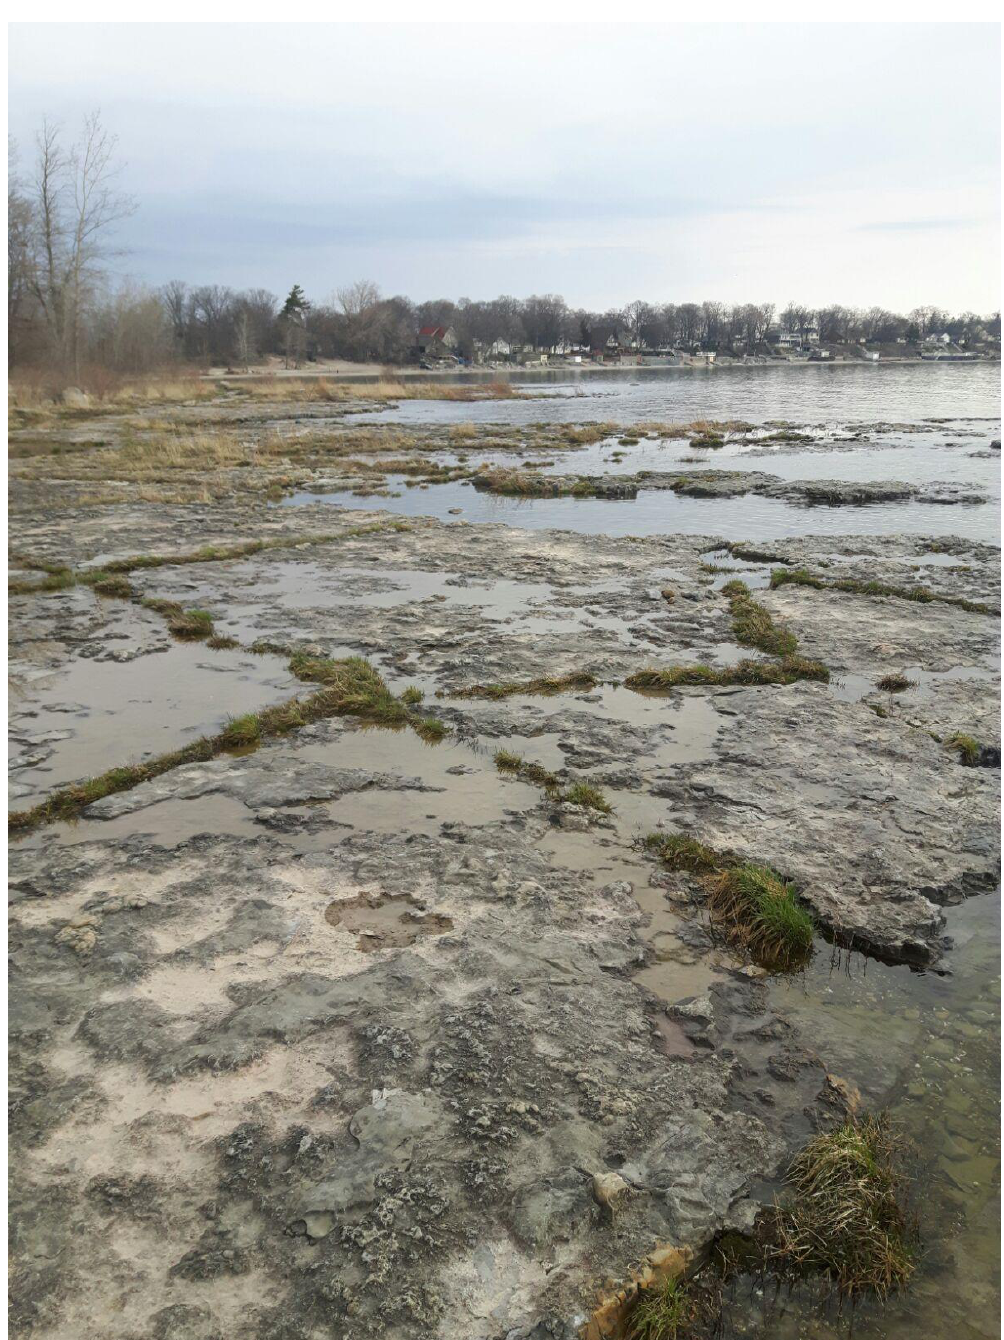
Figure 1. Lake Erie’s northeastern shoreline chert deposits. (Photo by Andrew Riddle